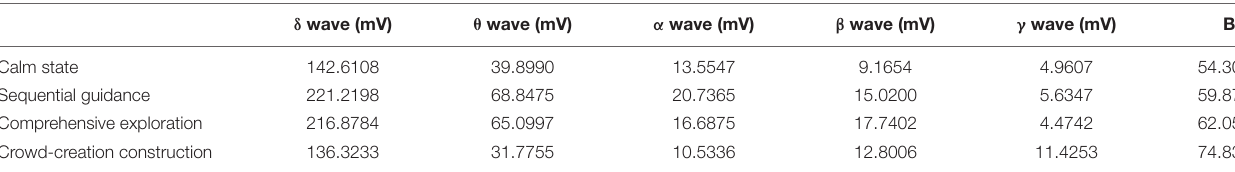
TABLE 4 | The variation coefficient of EEG eigenvalue and the mean value of input